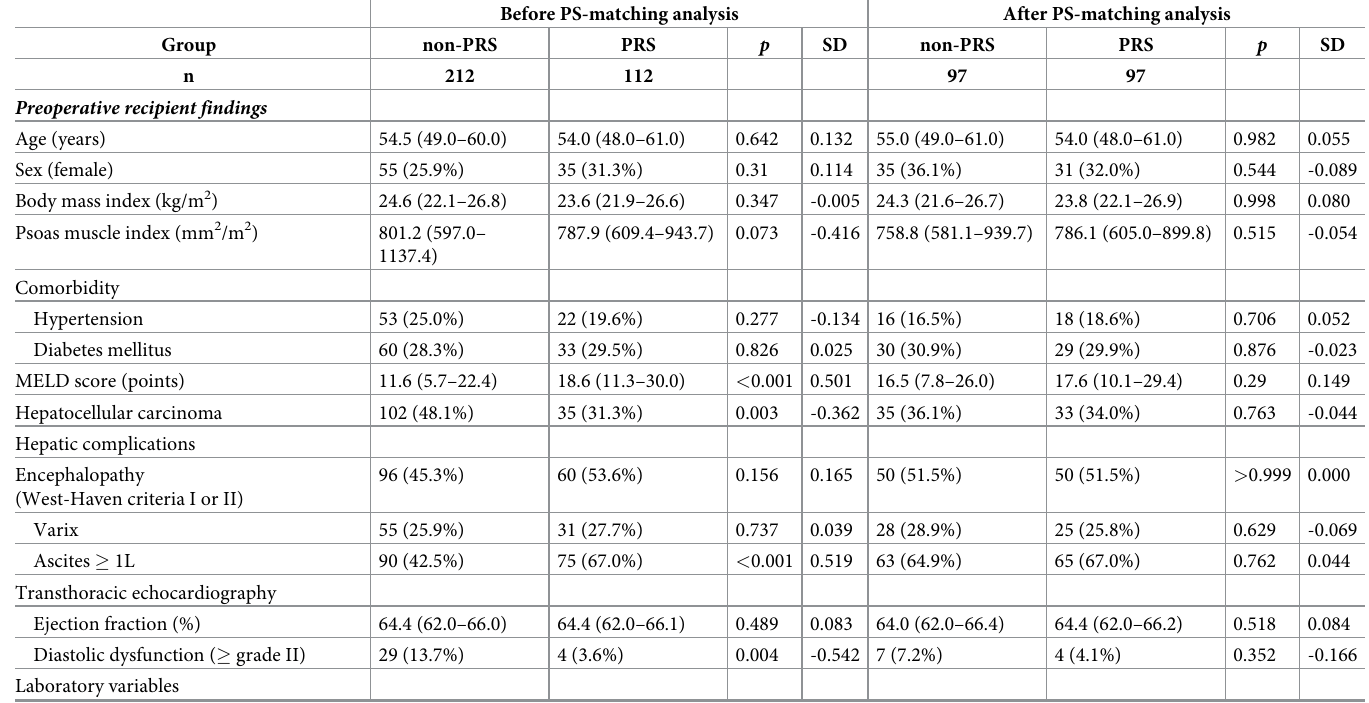
Table 1. Preoperative recipient and donor-graft findings before and after PS-matching analysis. Before PS-matching analysis After PS-matching